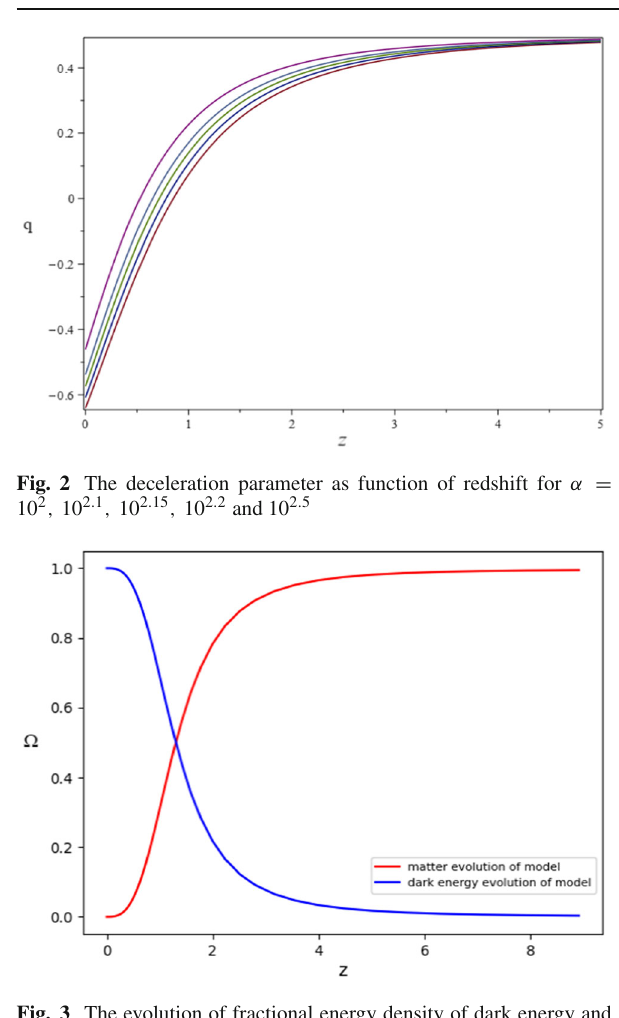
Fig. 3 The evolution of fractional energy density of dark energy and dark matter versus redshift for α = 10 2 . 15 . We have used modified version of COLOSSUS code to illustrate this plot